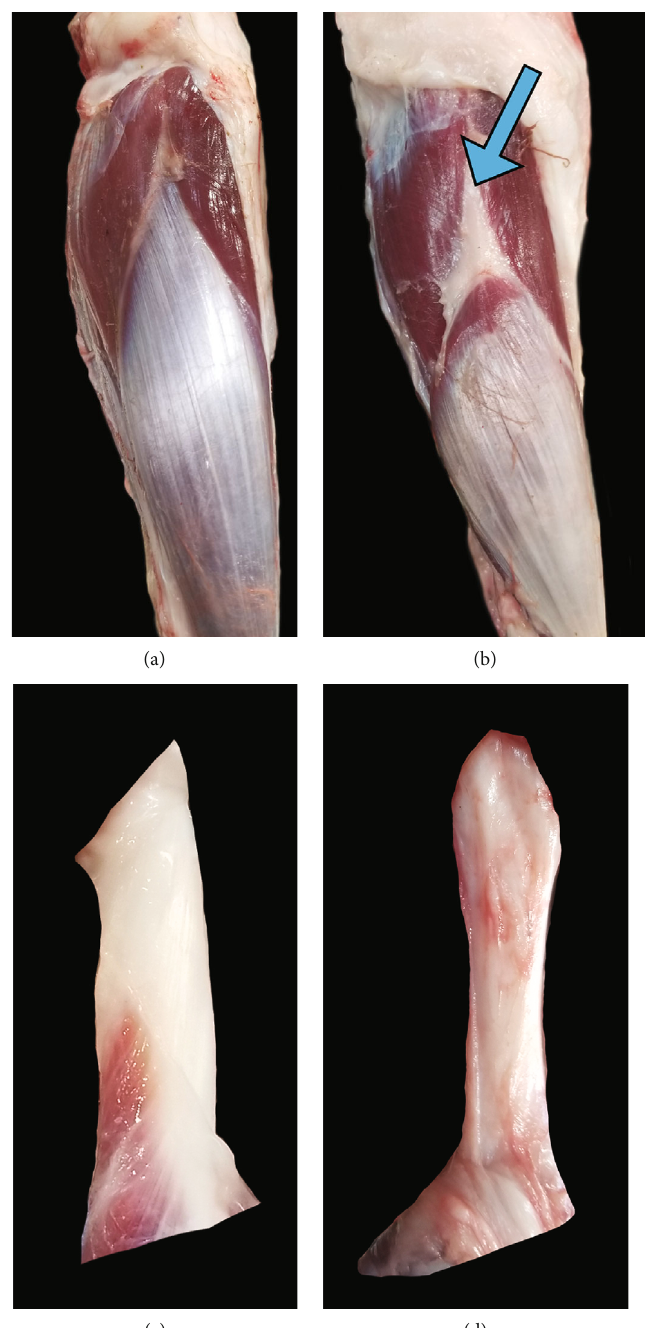
Figure 4: Gross changes in the peroneus tertius. Damage to the PT in six out of eight sheep that underwent CCLD was con fi rmed via postmortem dissection when compared to healthy una ff ected sheep ((a) intact and (b) disrupted). Gross structural changes can also be seen when comparing an intact proximal PT tendon (c) to a damaged proximal PT tendon (d). This may lead to variable joint stability between test